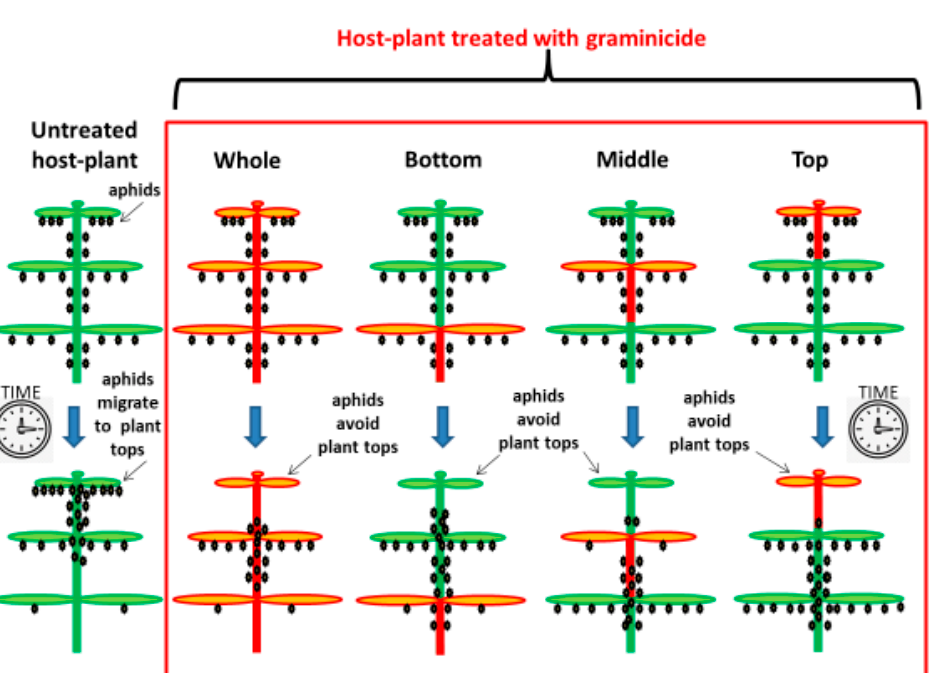
Figure 4. Scheme of the migration patterns of nymphs and adult hemp aphids ( Phorodon cannabis ) after herbicide application to the whole plant or individual parts of the host plant (top, middle or bottom third of the plant) (red box) and control plants untreated with the herbicide (left part of the scheme). The upper row shows the position of aphids at the beginning of the experiment (even distribution along the plant), and the bottom row shows the position of aphids 7 days later, i.e., 7 days after plant treatment (top of the plant in untreated variant; bottom and middle in the herbicide treated variant). The herbicide used in this study was Pantera 040 EC, the selective graminicide containing quizalofop-P-tefuryl (40 g · L − 1 , 4.38%, HRAC group 1: inhibition of Acetyl CoA carboxylase), commonly used to control weeds in hemp ( Cannabis sativa L.) in Poland. Aphids were applied to the host plants one day after